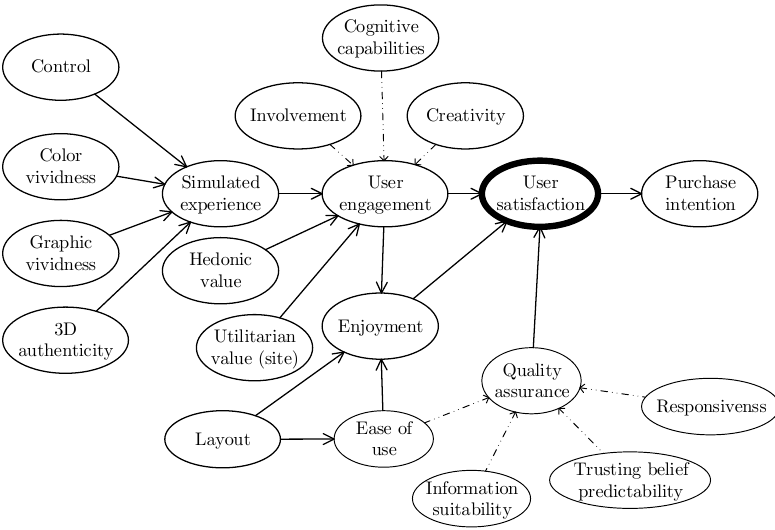
Figure 4. Conceptual framework of user satisfaction with a VR shopping